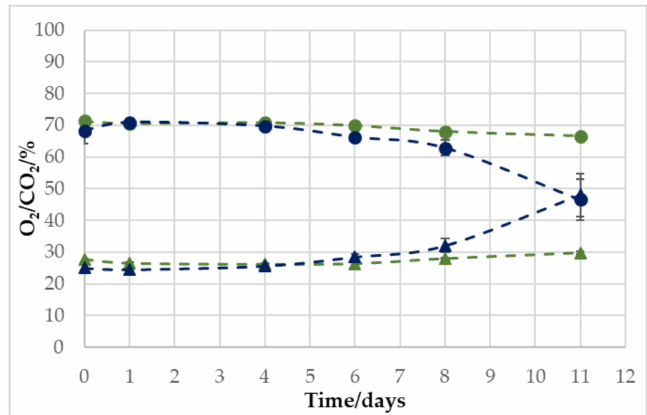
Figure 1. Development of the relative volume concentration of O 2 ( • / • ) and CO 2 ( (cid:78) / (cid:78) ) for a headspace:meat ratio of 6:1 ( • / (cid:78) ) and 3:1 ( • / (cid:78) ) at a storage temperature of 10 ◦ C for 11 days ( n = 2 for each measuring